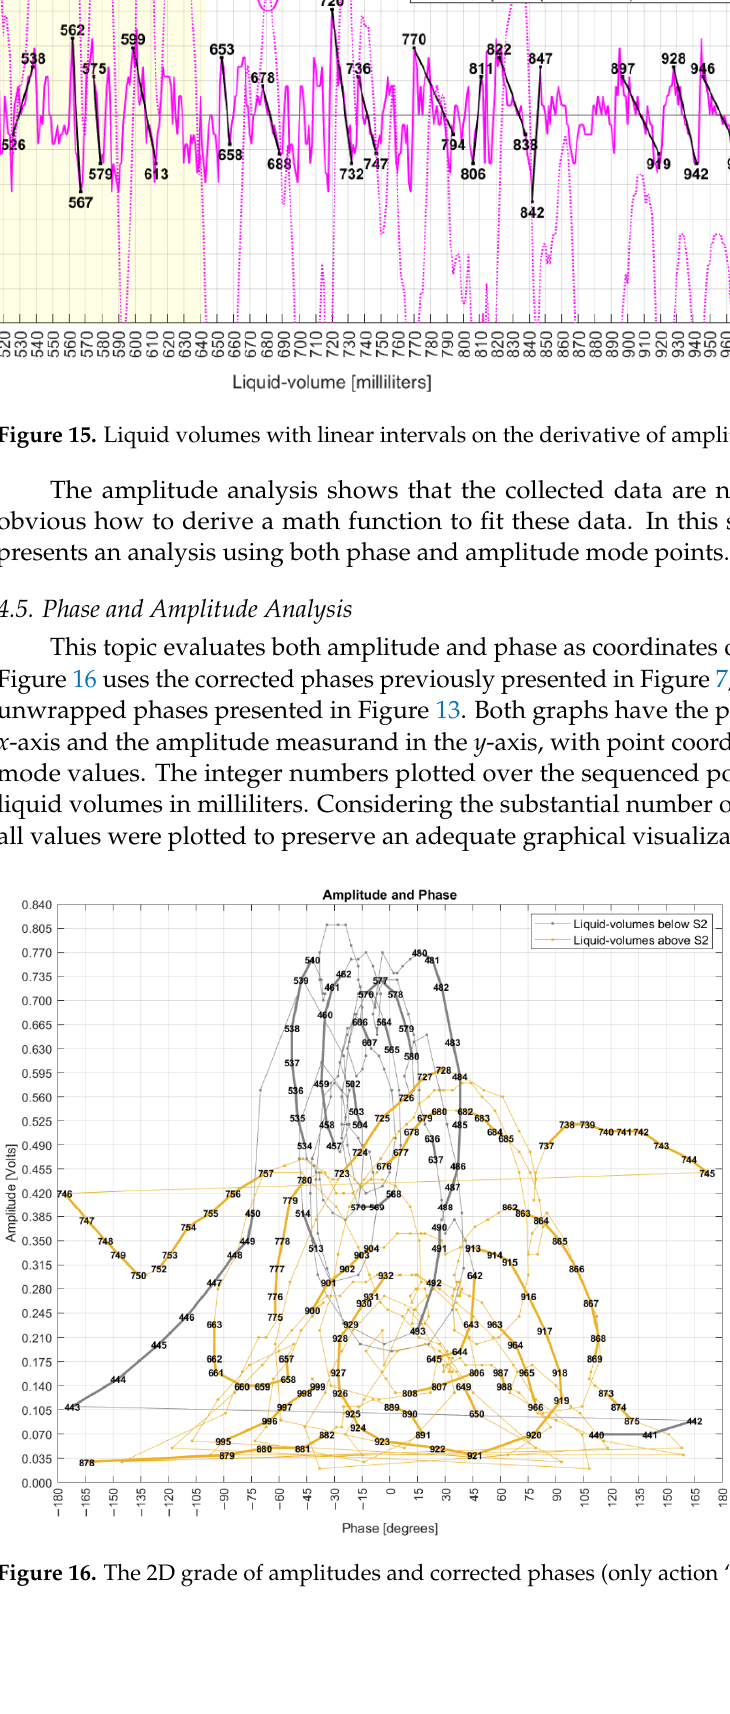
Figure 14. Liquid volumes with linear intervals on the amplitude series.